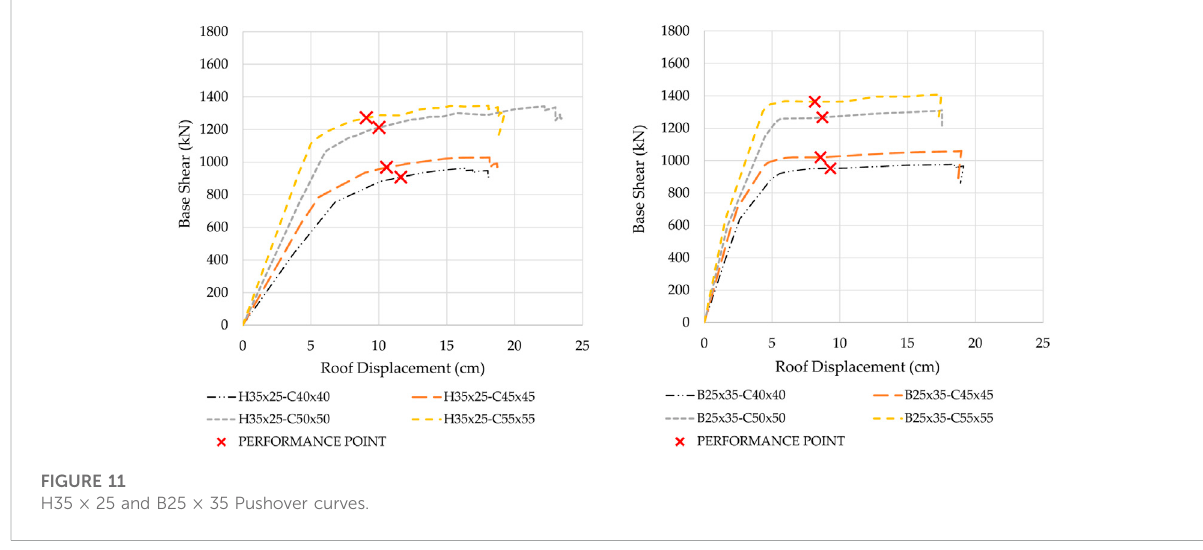
FIGURE 11 H35 × 25 and B25 × 35 Pushover curves.